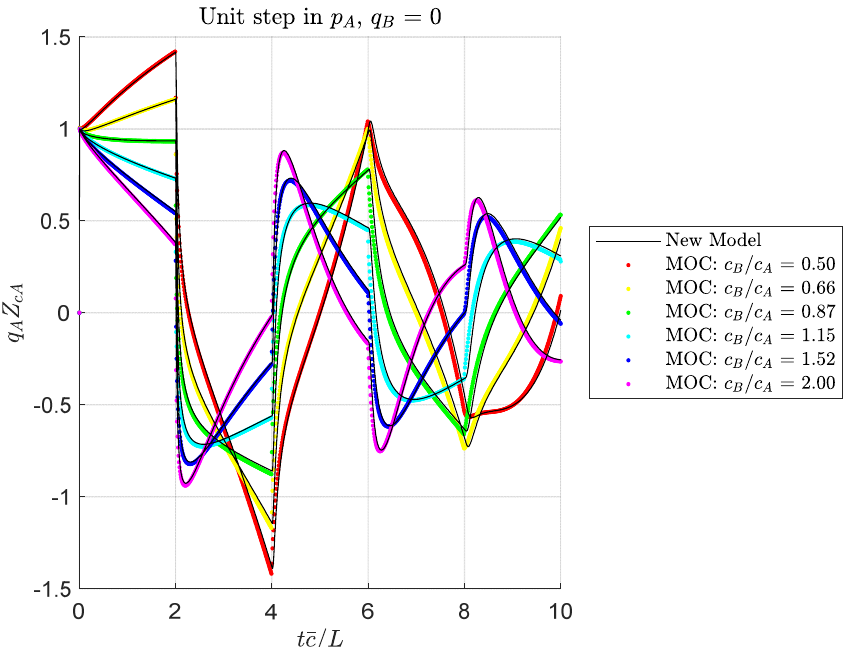
Figure 5. Inlet flow response to a unit step in inlet pressure, for a closed exit, showing effect of taper ratio.